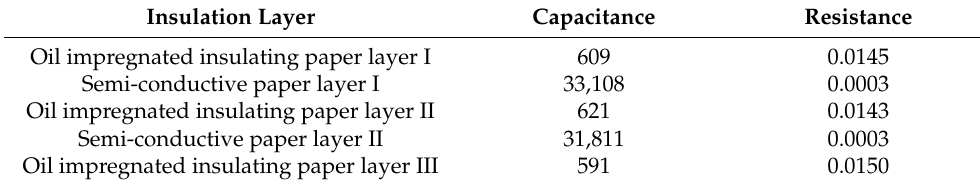
Table 1. Geometric capacitance and resistance of insulating layers.